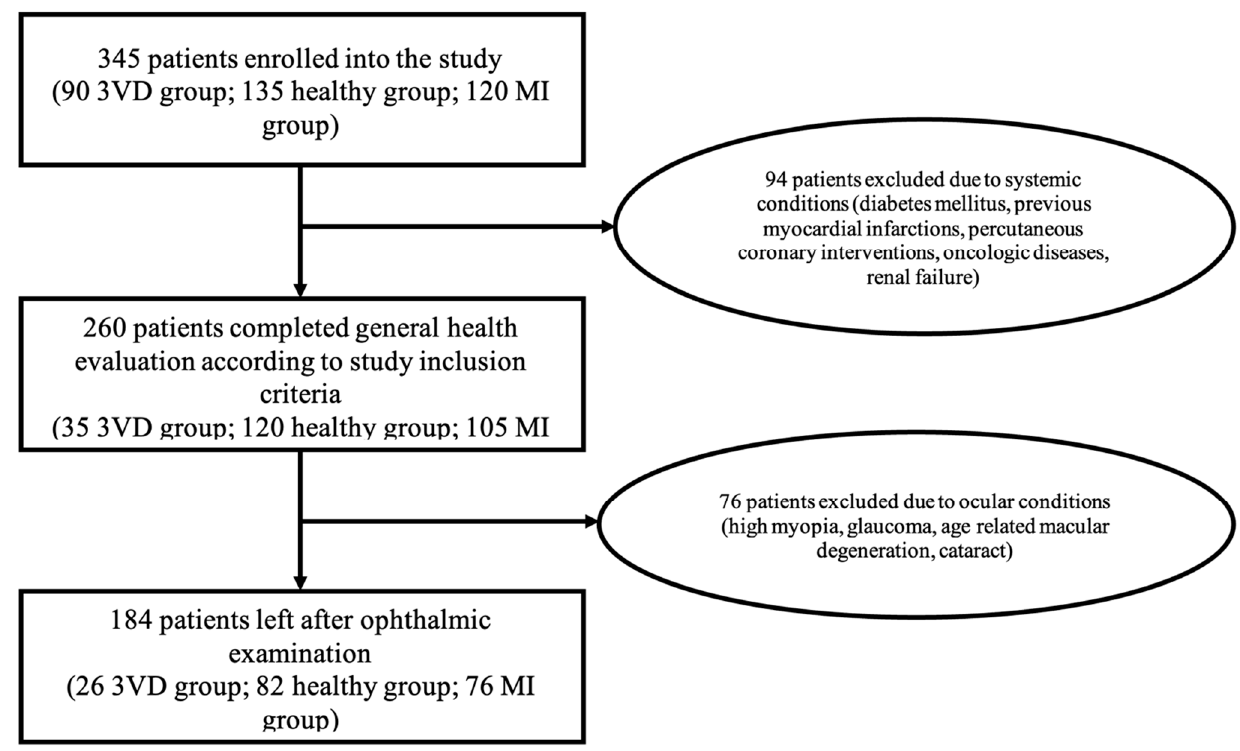
Figure 4. Patient enrollment. (MI—myocardial infarction, 3VD—three vessel disease group). Table 1. General and cardiovascular characteristics of all participants. Table 1. General and cardiovascular characteristics of all